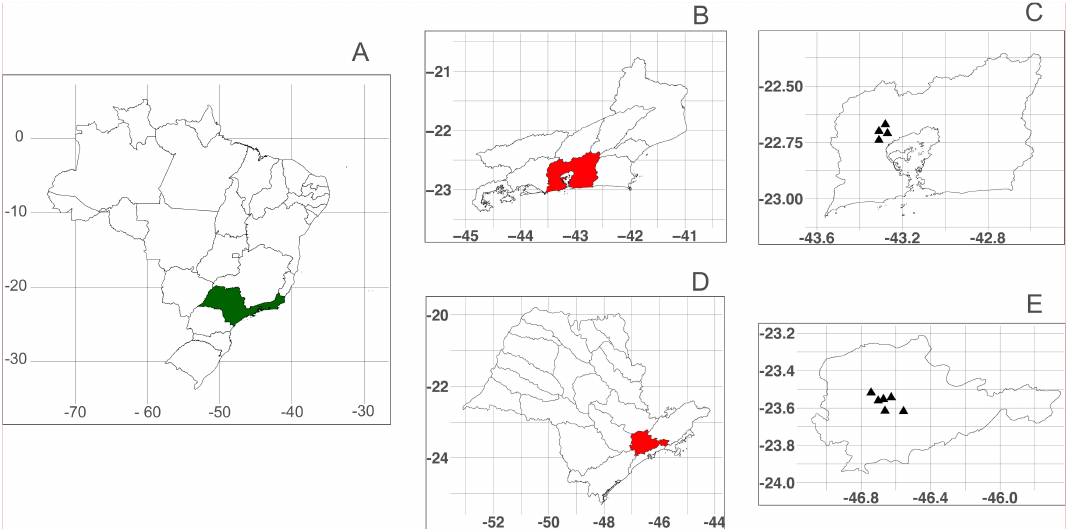
Figure 1. The map of Brazil ( A ) highlighting the states of Rio de Janeiro ( B ) and São Paulo ( D ). Four ground stations in RJ’s Baia de Guanabara hydrographic region ( C ) and six ground stations in SP’s Alto Tiete hydrographic region ( E ) were selected for analysis in this